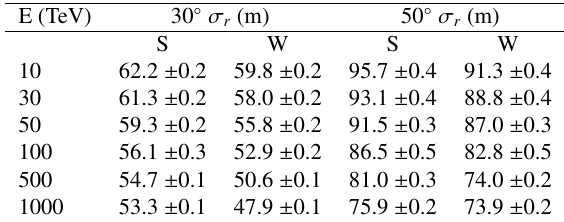
Table 3: Standard deviation of the distance of muons from the shower axis r arriving at the detector plane, z = 125 m, for summer (S) and winter (W) for zenith angles θ = 30 ◦ , and θ = 50 ◦ .